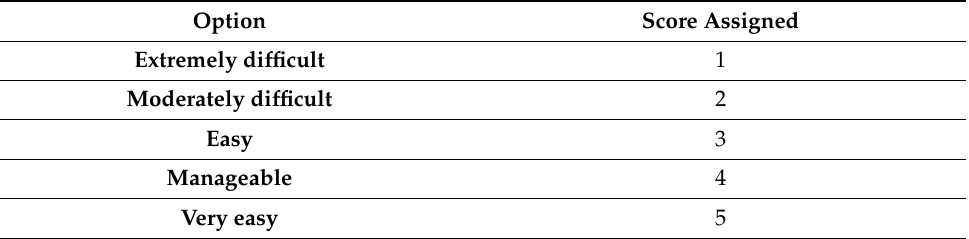
Table 6. Scores assigned to the different answer options in the group of questions regarding physical